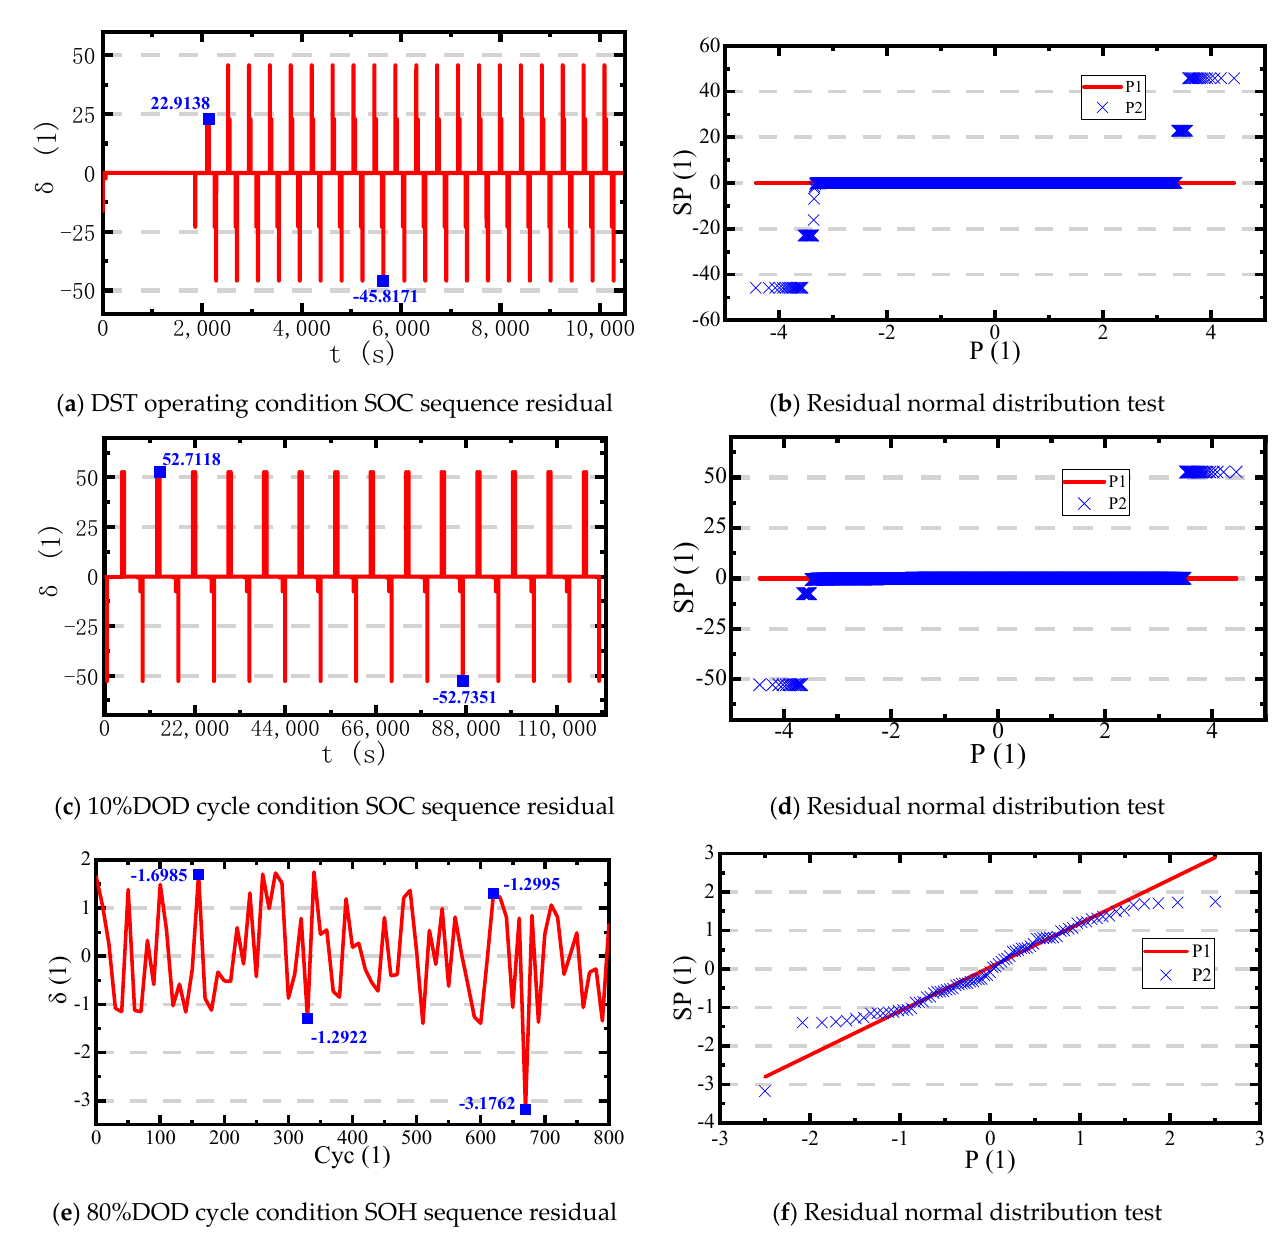
Figure 8. Q-Q chart test whether the residuals conform to the normal distribution. Figure 8a,c,e (are the residual sequence of samples under different working conditions, and Figure 8b,d,f are the Q–Q diagrams corresponding to the residuals of each working condition. SP represents the quantile of the input sample, and P represents the standard normal quantile. Compare the SP and P series to test whether the residuals are close to a normal distribution. Curve P1 represents the standard normal distribution, and curve P2 represents the distribution of the residuals. The higher the degree of overlap between curve P2 and curve P1, the closer the residual is to a normal distribution. It can be seen from Figure 8 that the residuals are close to the normal distribution under the three working conditions.